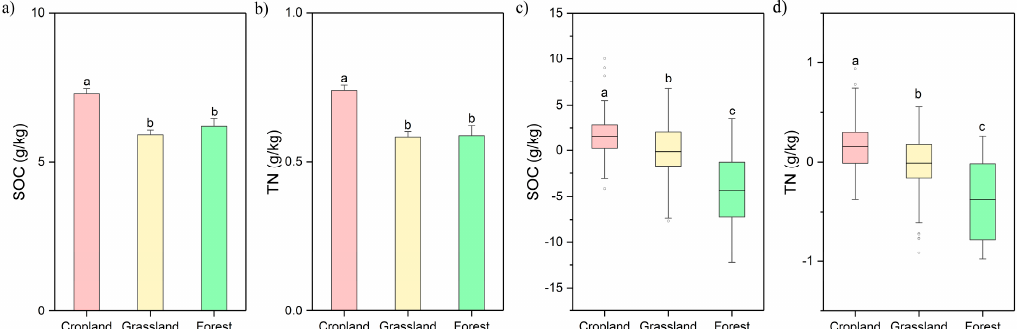
Figure 4. Soil C and N for different prior land uses: ( a ) Soil organic carbon content in 2015, ( b ) Total nitrogen content in 2015, ( c ) Change of soil organic carbon content, ( d ) Change of total nitrogen content. Note: 1. Group differences after one-way ANOVA ( p < 0.05) was indicated by different lowercase letters. 2. Bar length gives the mean value, vertical whisker of bar for each column indicate standard errors of the mean. 3. Line within the boxes gives the median value, box means the 25th and 75th percentile, whisker of box represents 1.5 times the length of the box from either end of the box (1.5 times the interquartile range), circle represents outliers and extremes. The same as below.